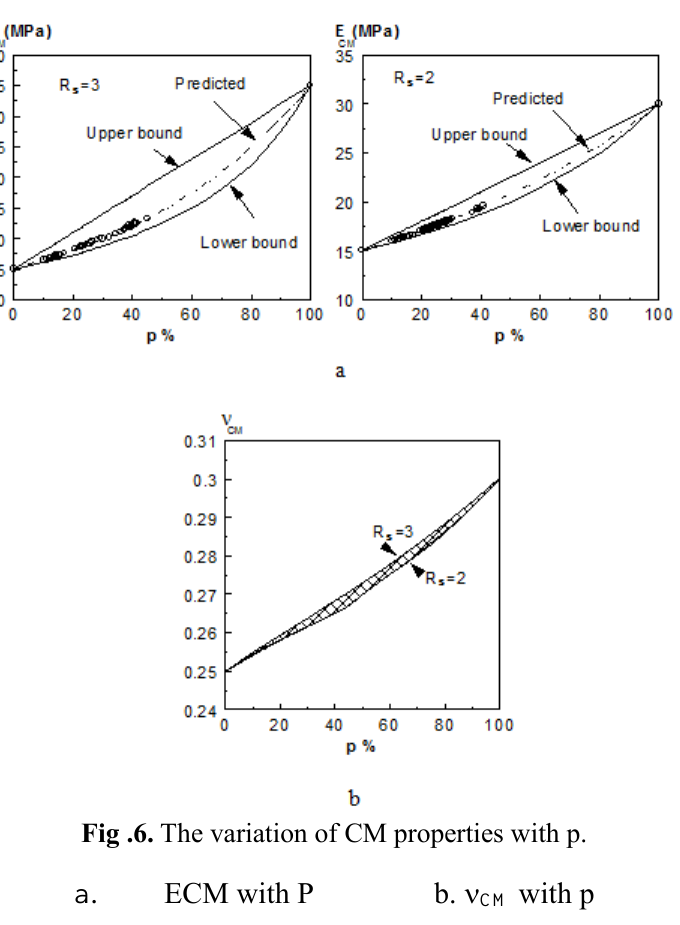
Fig .6. The variation of CM properties with p.